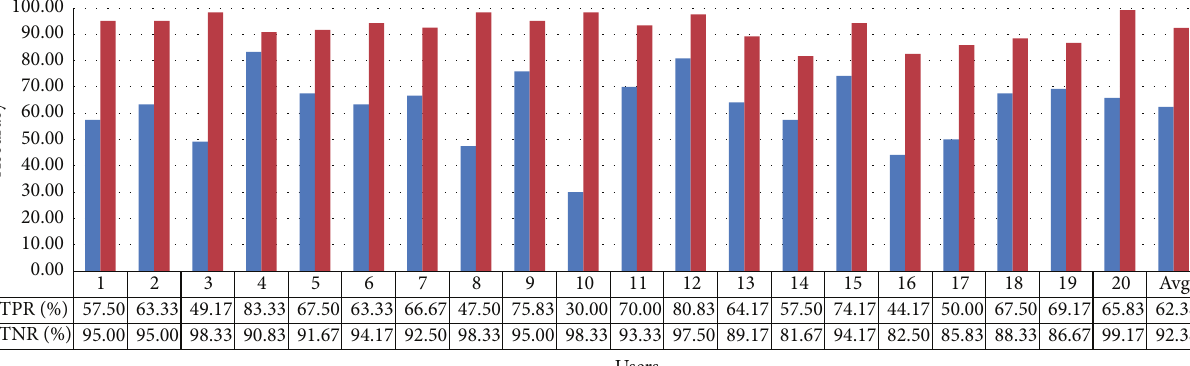
Figure 19: Accuracy of selecting the heater using gaze estimation method